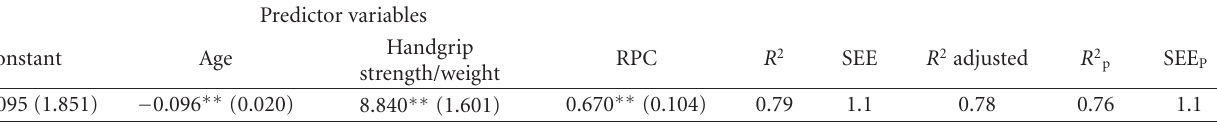
Table 2: Prediction model after stepwise multiple regression (validation group).